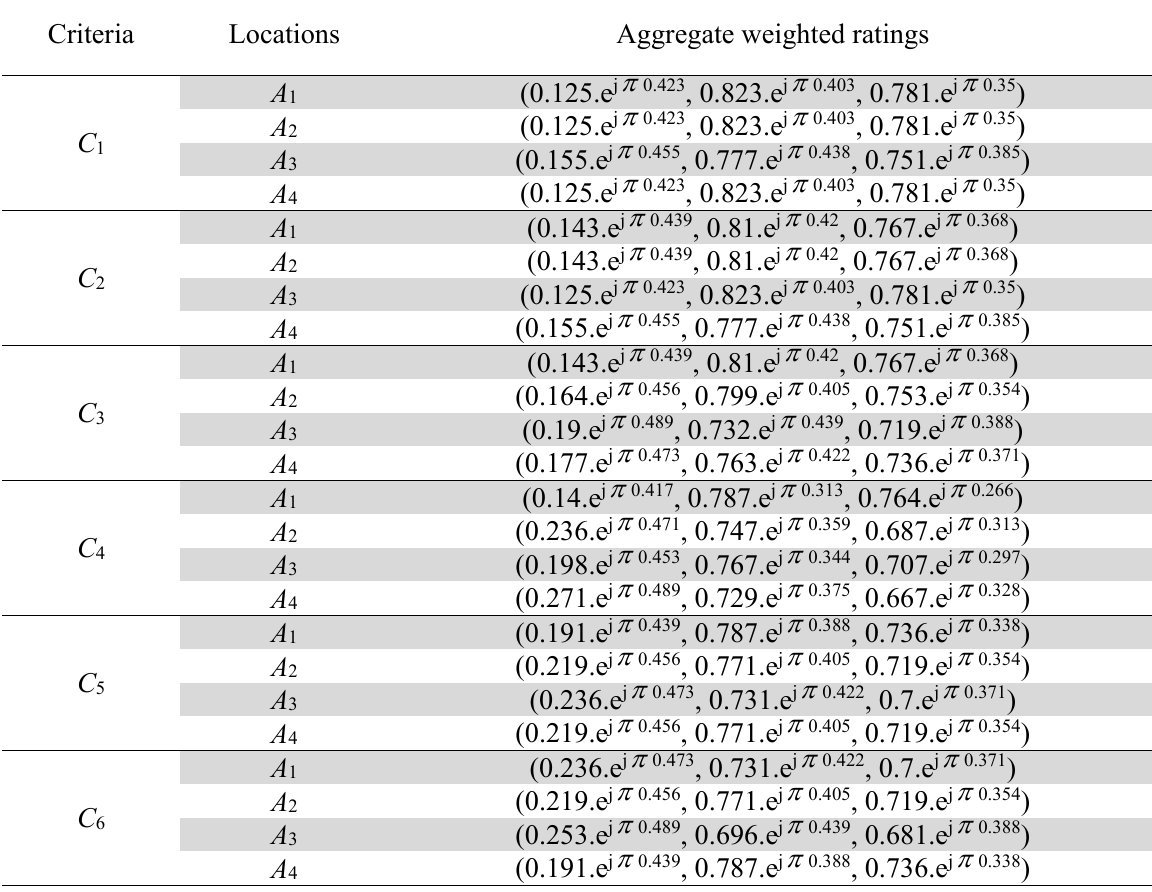
Aggregate weighted rating value of each location